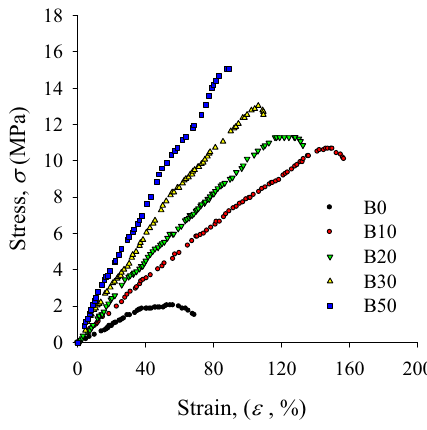
Figure 2: Stress – strain curves of carbon black - fi lled NR/IIR composites.